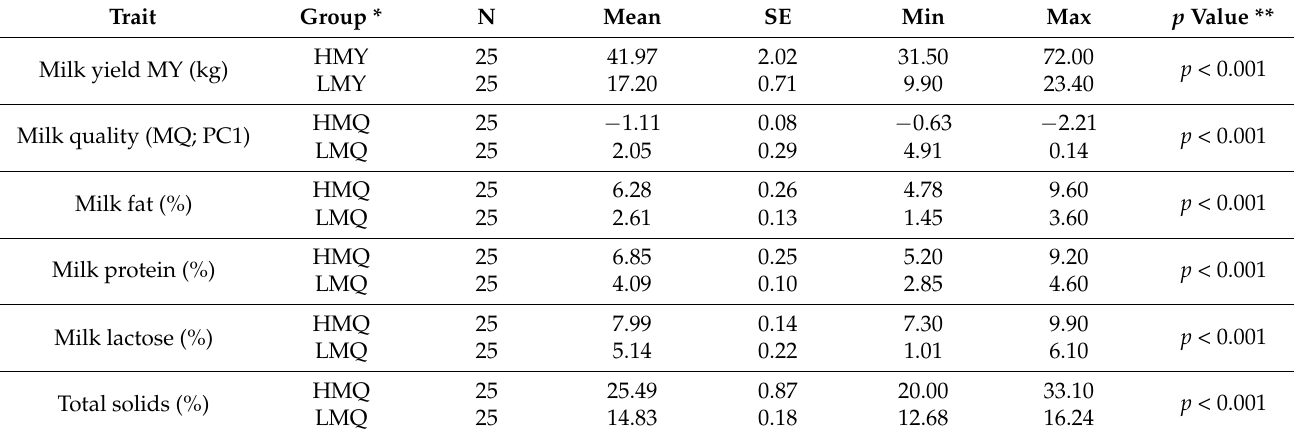
Table 1. Descriptive statistics of milk performance traits.